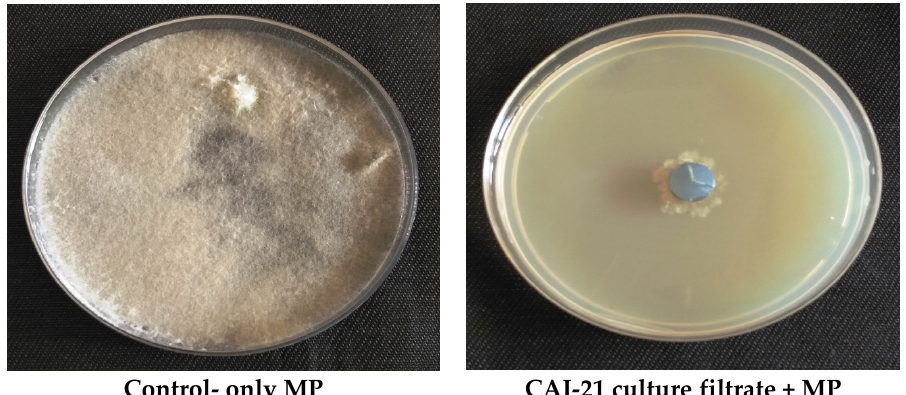
Figure 2. Growth inhibition of M. phaseolina (MP) caused by the S. albus CAI-21 by secondary metabolite production assay. Left picture: 0.1 mL of methanol was incorporated into the potato dextrose agar (PDA) plate followed by inoculation with 4 mm diameter of MP. Right picture: 0.1 mL of organic fraction in methanol of CAI-21 culture filtrate was incorporated into the PDA followed by inoculation with 4 mm diameter of MP. The plates were incubated at 28 ± 2 °C for 120 h in the dark.